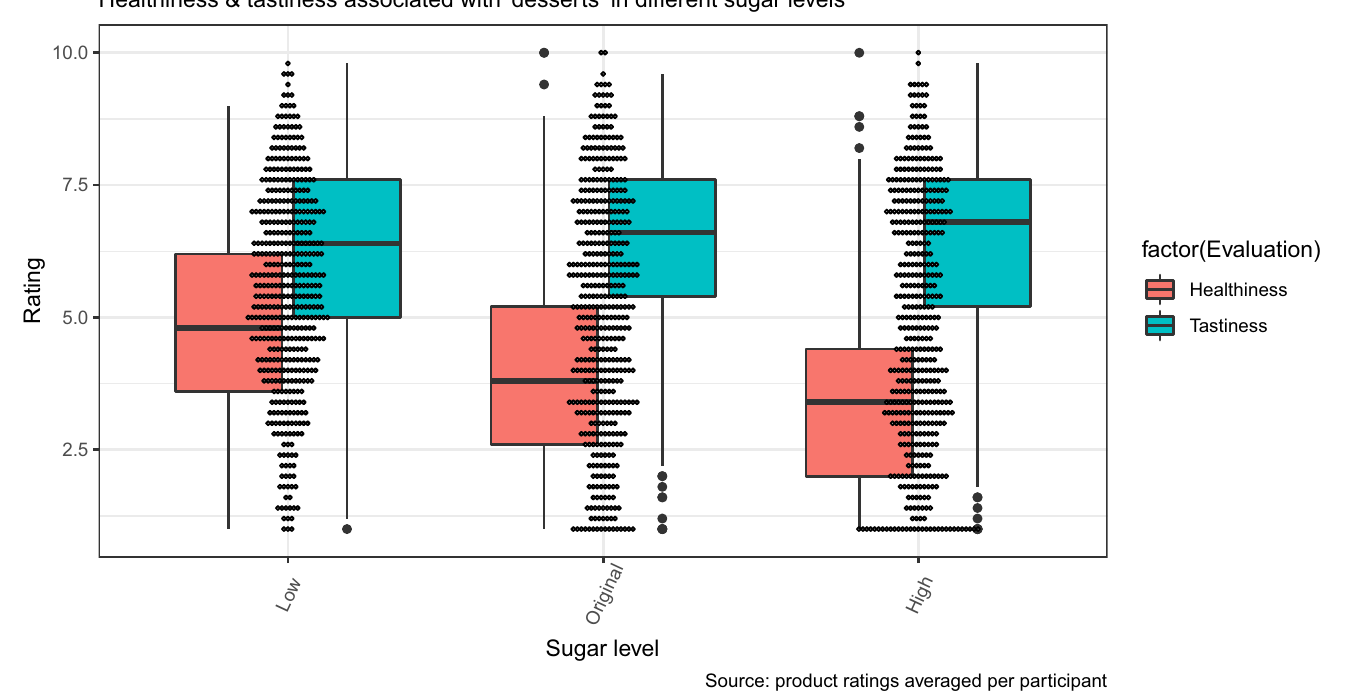
Fig 1. Box plot and dot plot depicting the healthiness and tastiness ratings of products with low, original and high sugar level content. Note . The top of the box represents the 75th percentile and bottom of box is 25th percentile, while the dark line inside the box is the median. The end points of the lines (whiskers) are at a distance of 1.5 � Inter Quartile Range (the distance between 25th and 75th percentiles). The dots show the distribution of participants’ average healthiness/tastiness product ratings across products with different sugar levels.